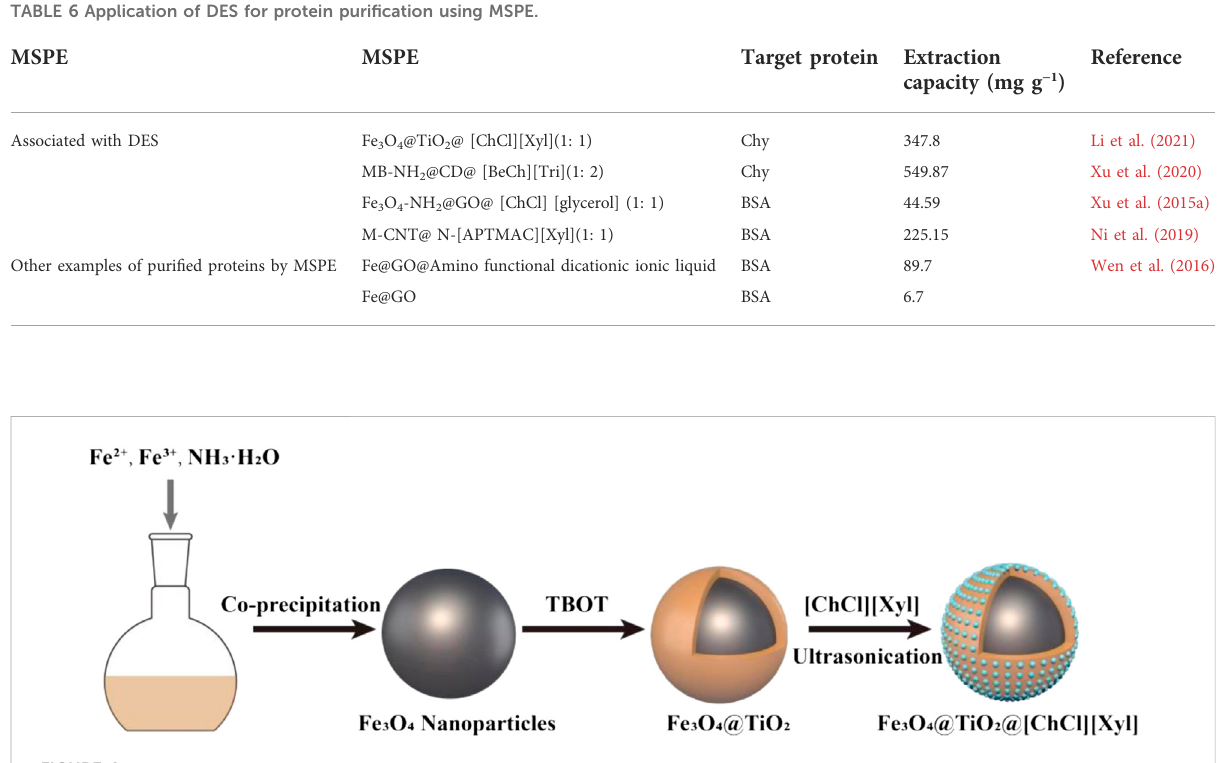
FIGURE 4 Magnetic titanium dioxide nanoparticles modi fi ed with